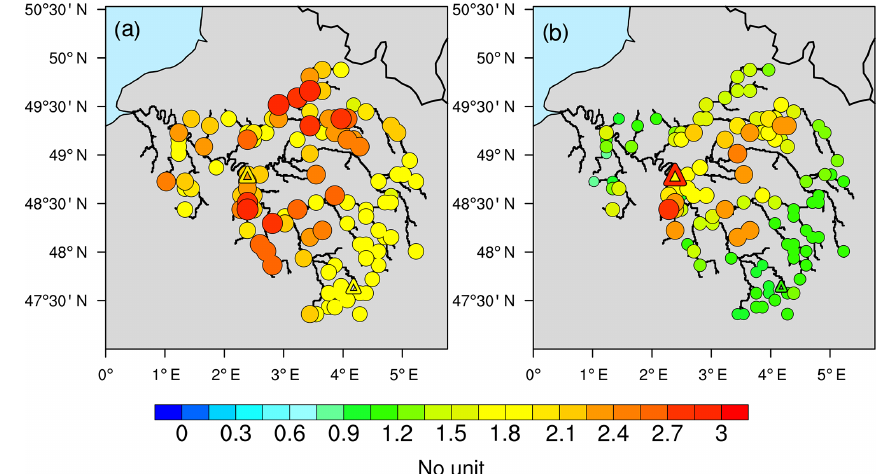
Figure 13. (a) Ratio of the number of days with river flow equal to or greater than the 95th percentile between the positive multidecadal phases of the Seine river flows (1910–1930 and 1975–1995) and the negative phases (1885–1905 and 1940–1960) calculated for the reconstruction (dots), and for the two available long-term observation series (triangles; see Fig. 1). Only the days of the flood season are used (November to April). (b) Same as panel (a) for the days with river flows equal to or lower than the 5th percentile between the negative and the positive multidecadal phases, considering the whole